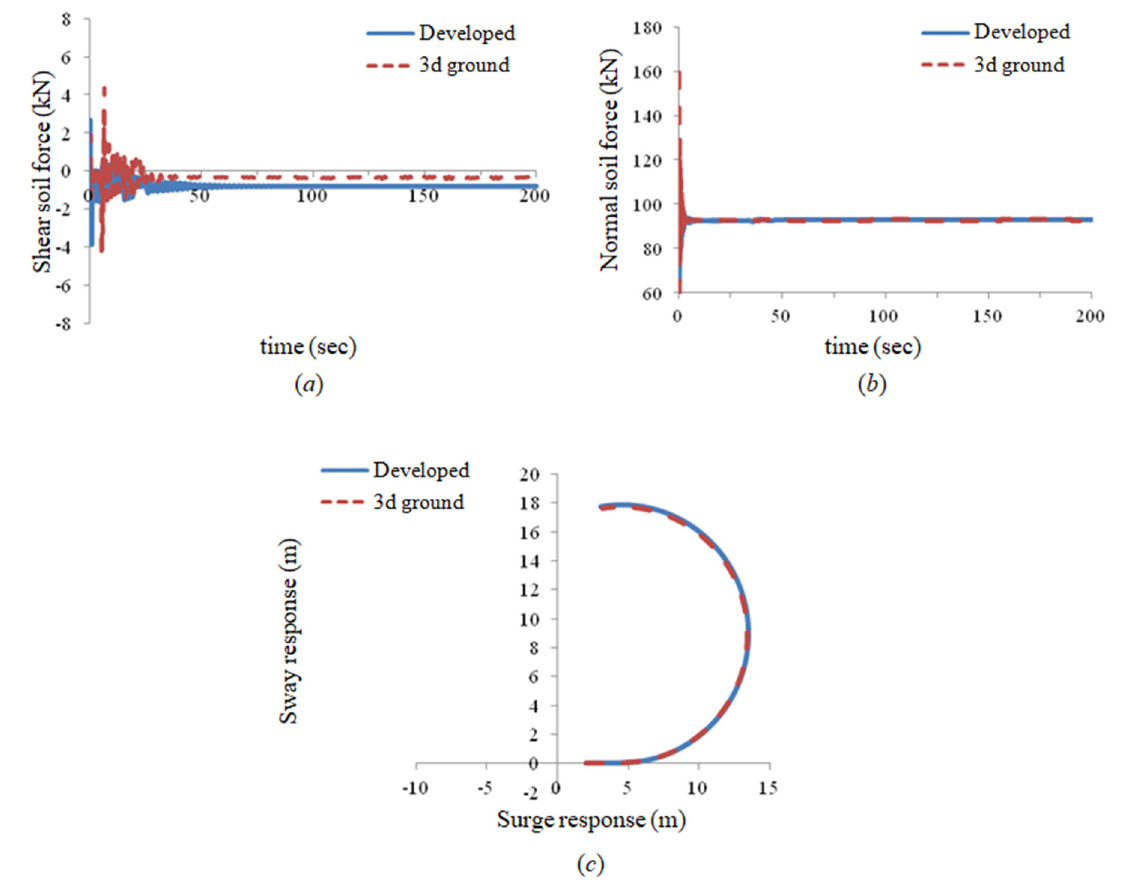
Figure 34. Comparison of the steering drive dynamic analysis results between the developed method and 3D ground model: ( a ) shear soil contact force acting on mining robot, ( b ) normal soil contact force acting on mining robot, ( c ) steering radius of the mining robot.